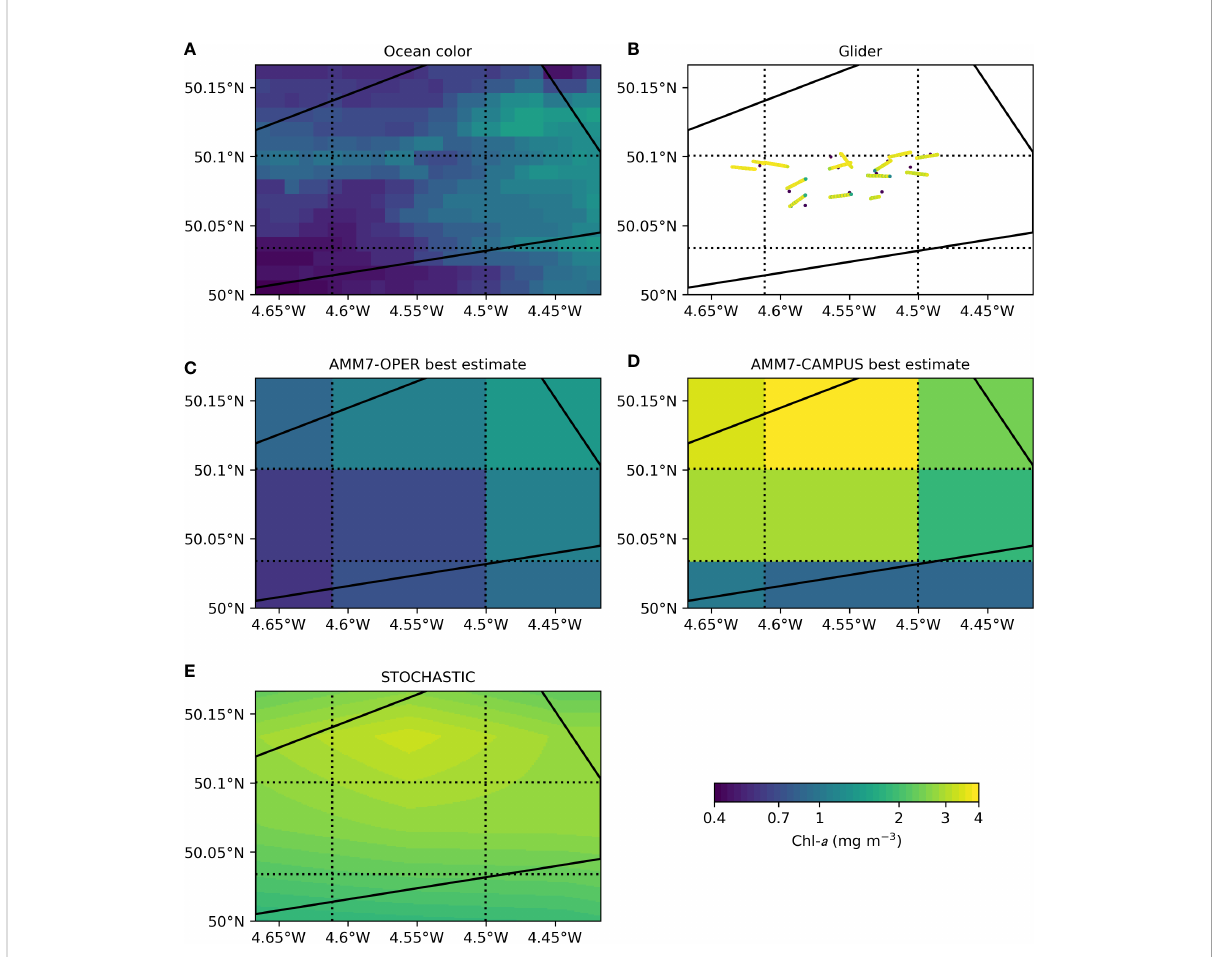
FIGURE 9 Chl- a in the glider region on 26 April 2021, from (A) ocean color, (B) glider observations in the upper 10 m, (C) AMM7-OPER surface best estimate, (D) AMM7-CAMPUS surface best estimate, (E) STOCHASTIC, fi rst four-hour prediction of the day. The solid black lines denote the region the glider was constrained to stay within. The dotted black lines denote the AMM7 model grid. Note the use of a log color